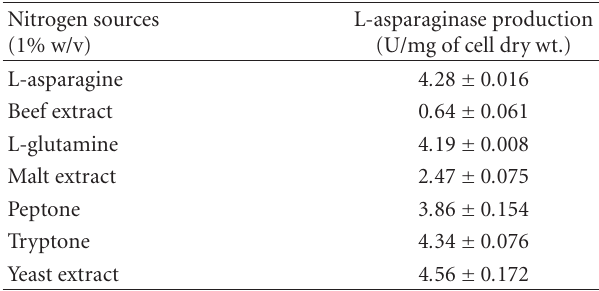
Table 3: L-asparaginase production by Nocardia levis grown in modified ISP-5 broth amended with di ff erent nitrogen